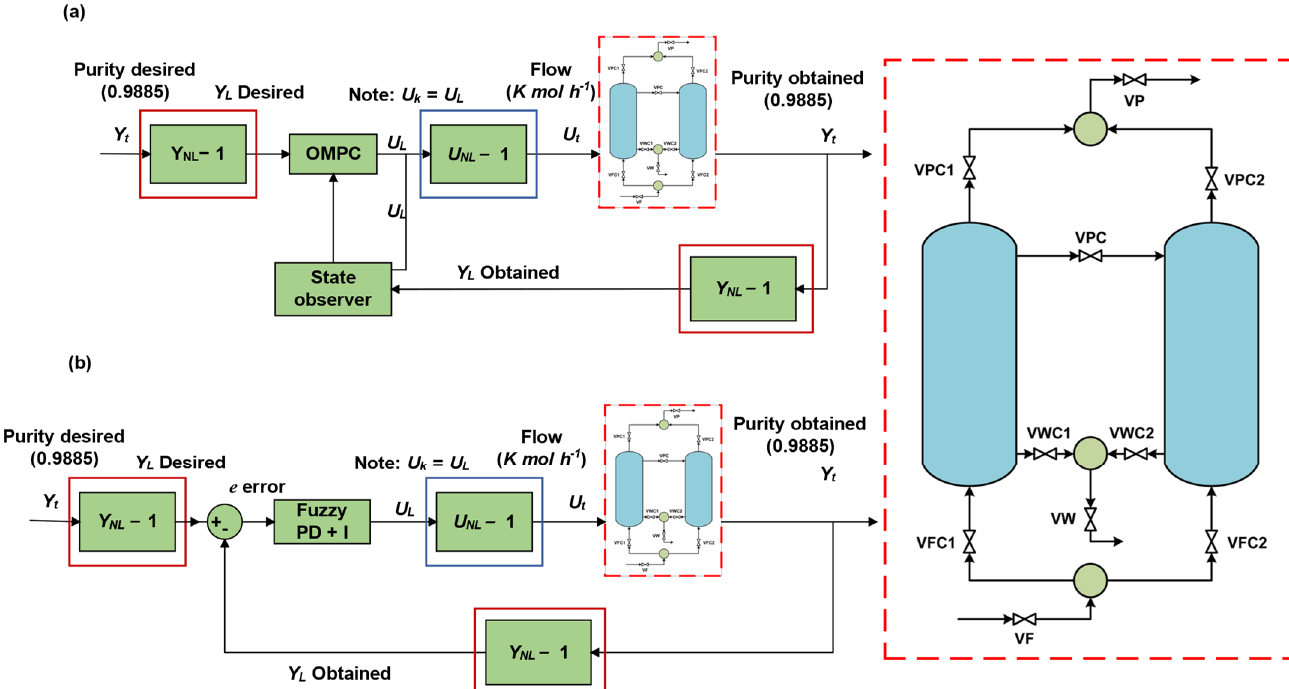
Figure 6. Simulation implementation within the Aspen Plus/Simulink environment of ( a ) the optimal MPC and ( b ) fuzzy PD + I to control the adsorption plant cited from Jesse [81]. U L and Y L are the input–output control signals, whereas U t and Y t are the input–output signals of PSA process. VP, VF and VW are product valve, feed valve and waste valve, respectively. Readapted with permission from Ref. [81]. Copyright 2020 Elsevier.